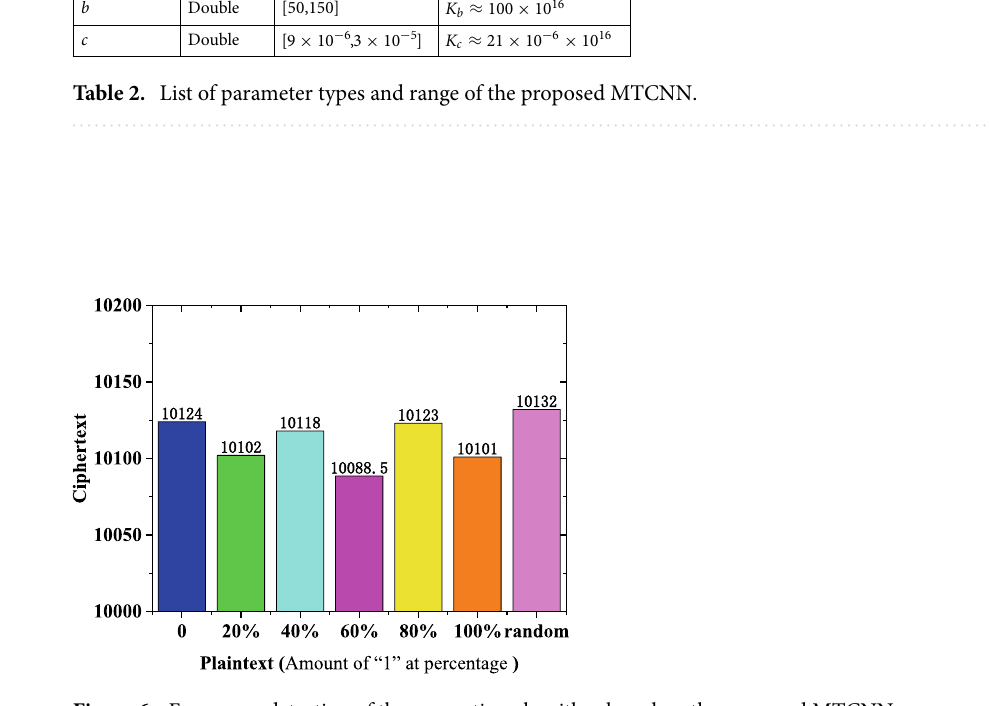
Figure 6. Frequency detection of the encryption algorithm based on the proposed